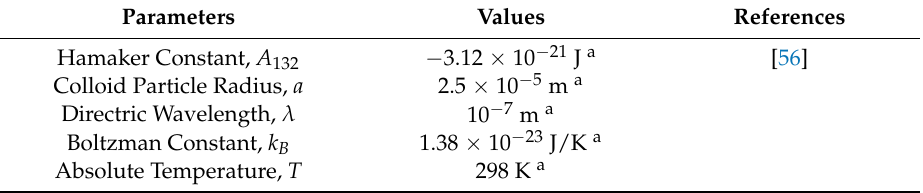
Table 2. Parameter values of van der Waals interaction employed in the theoretical considerations.